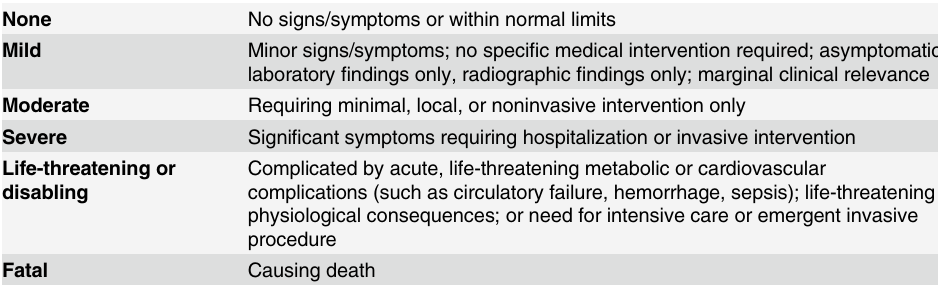
Table 2. Categorizing of adverse events based on signs and